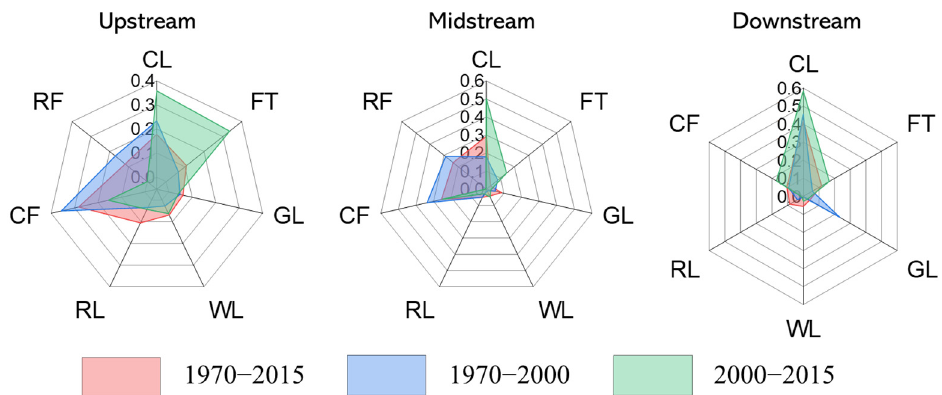
Figure 5. The contributions of climate change and human activities to streamflow consumption during